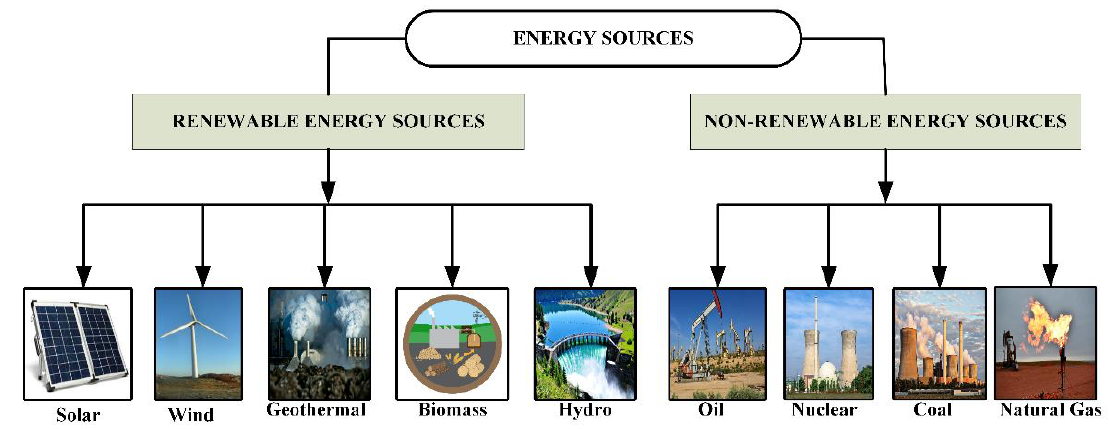
Figure 2. Types of energy sources [26].